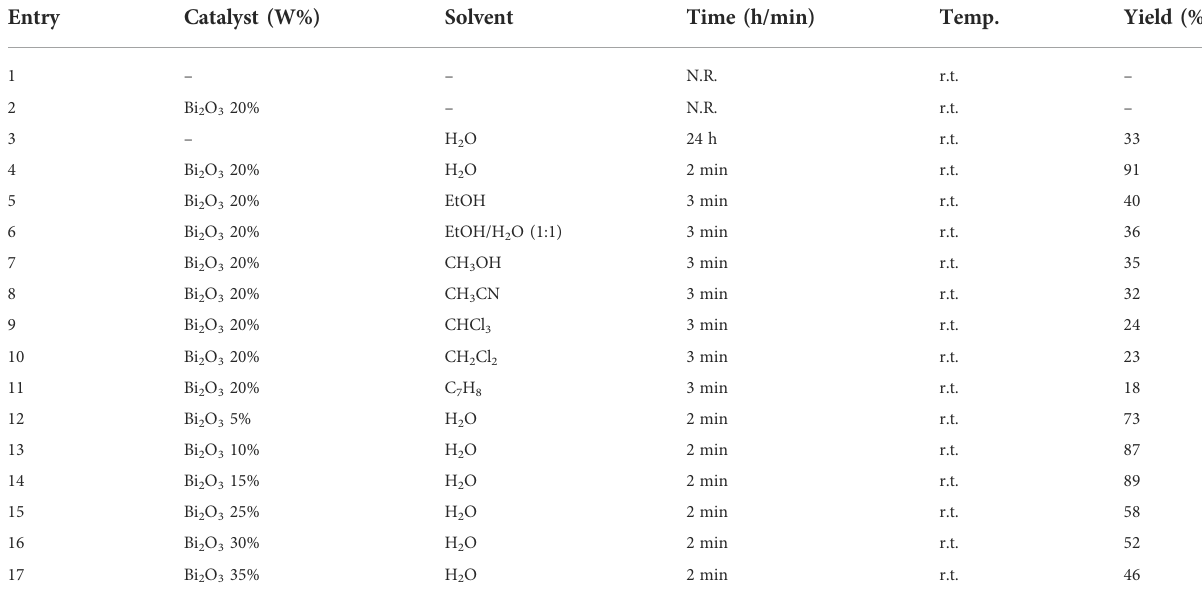
TABLE 1 Synthesis of 3j in the presence of different solvents and amounts of catalyst.